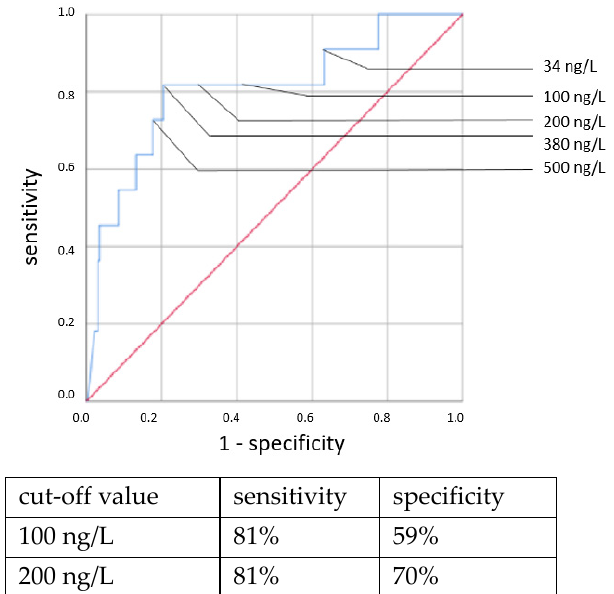
Figure 1. IL-6 concentration. Culture-positive EOS.